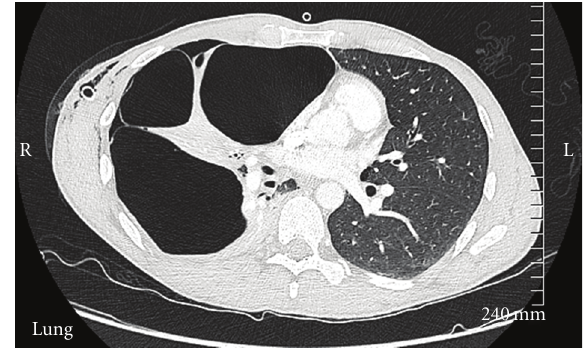
Figure 3: Chest CT at di ff erent section showing bullous disease. nology and cardiothoracic surgery to further delineate plans for surgery at the appropriate